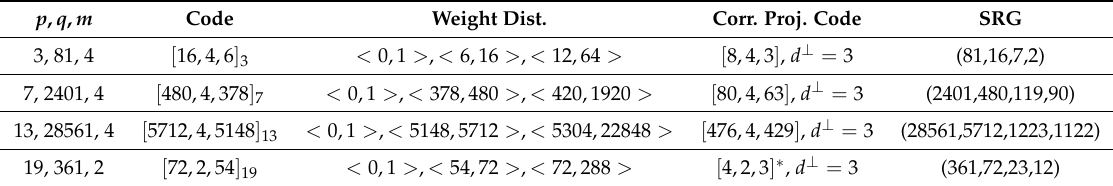
Table 4. Two-weight trace codes from powers of